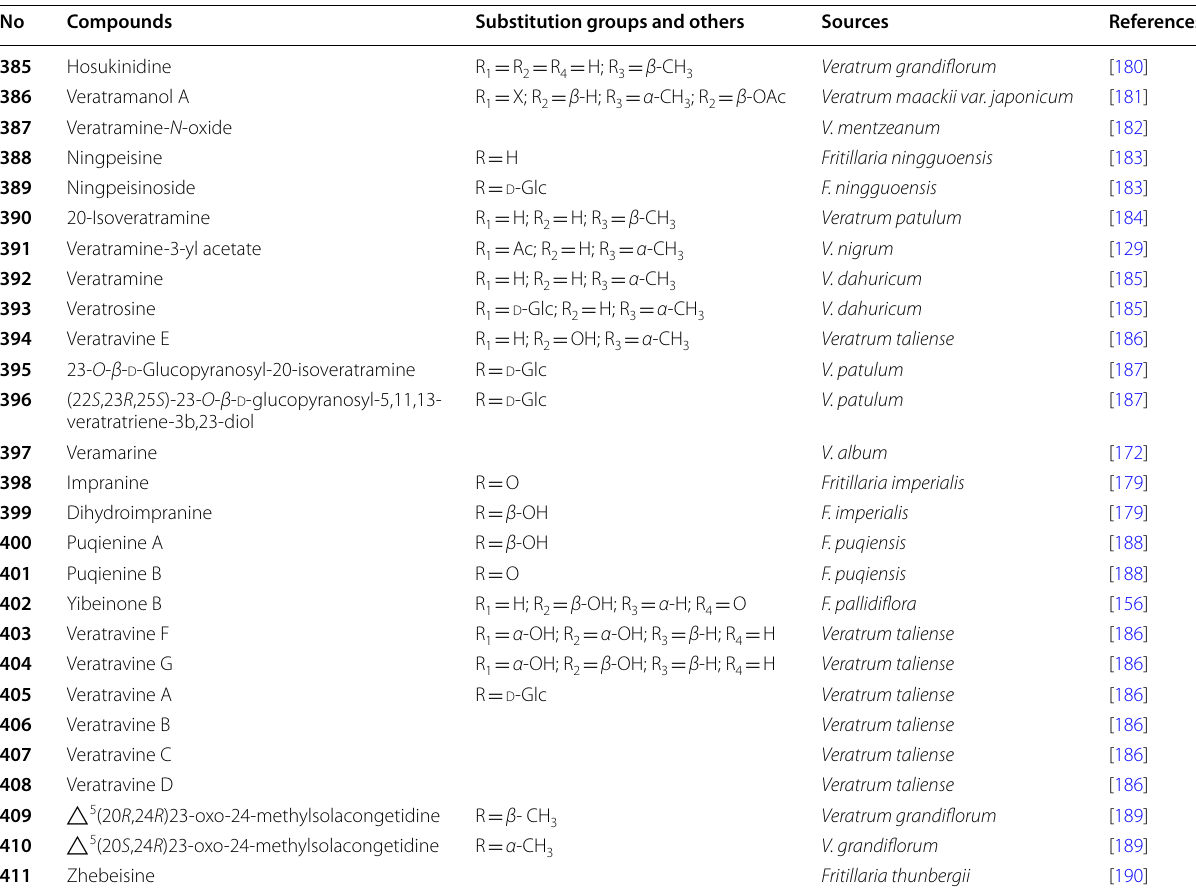
Table 7 Structures and sources of veratramine type steroidal alkaloids 385–411